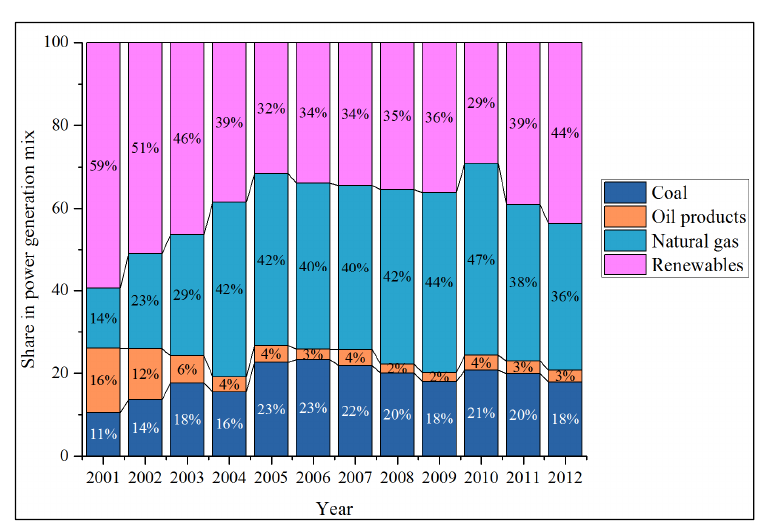
Figure 19. Vietnam: power generation